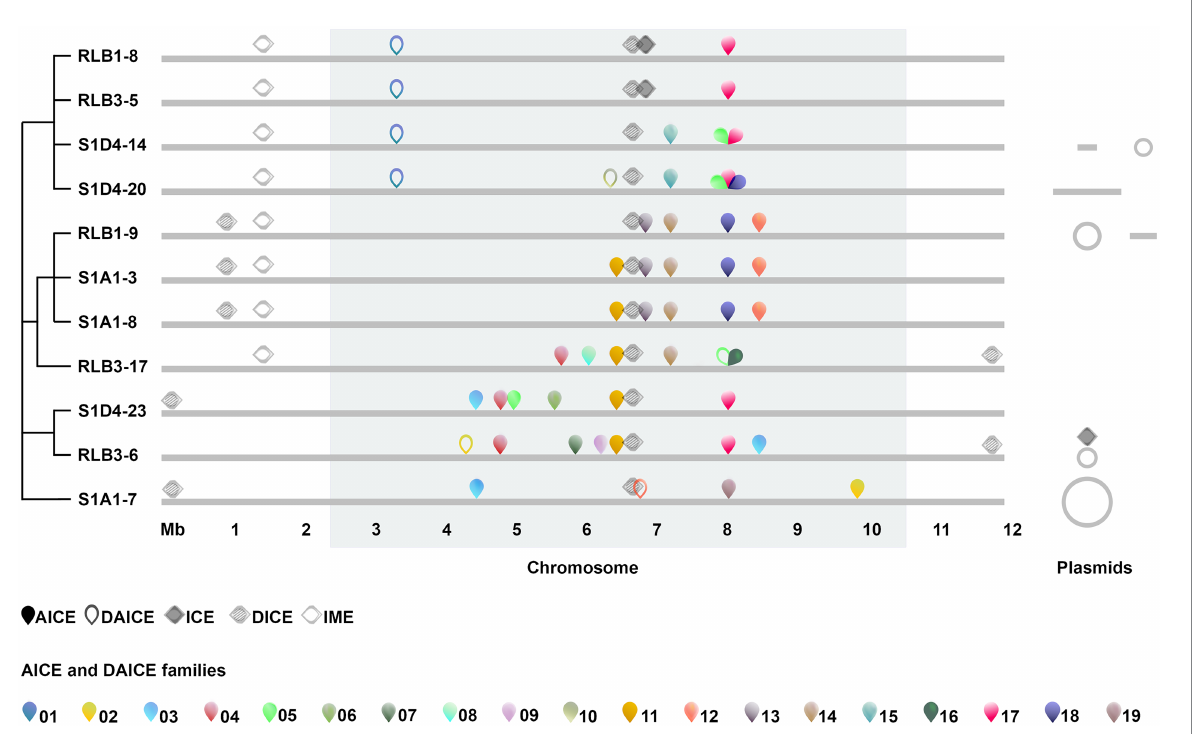
FIGURE 1 Prevalence and chromosomal distribution of conjugative elements in the Streptomyces population. Conjugative and integrative elements (AICEs, DAICEs, ICEs, DICEs, IMEs) are positioned along the chromosome (light grey line) of each isolate (relative to the RLB1-8 genome). The core- genome is highlighted in the grey band (2.4 and 1.4 Mb) are devoid of conserved genes on the left and right arms. The scale of 1–12 Mb corresponds to the genomic positions. ICEs, DICEs, and IMEs are represented by full, striped and empty diamonds respectively; AICEs and DAICEs are indicated by full and open pins, respectively, and each AICE family is represented by a color. Evolutionary relationships between strains are represented by a modified cladogram from Tidjani et al. (2020). Linear and circular plasmids when present are displayed on the right of the chromosome (note that representation is not proportional to their